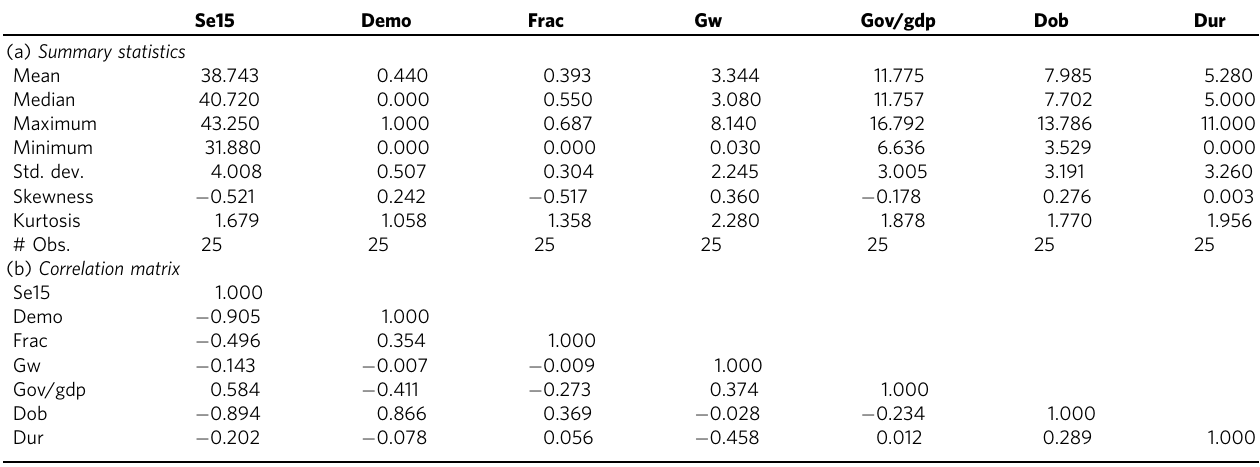
Table 1 Descriptive statistics and correlation matrix of main